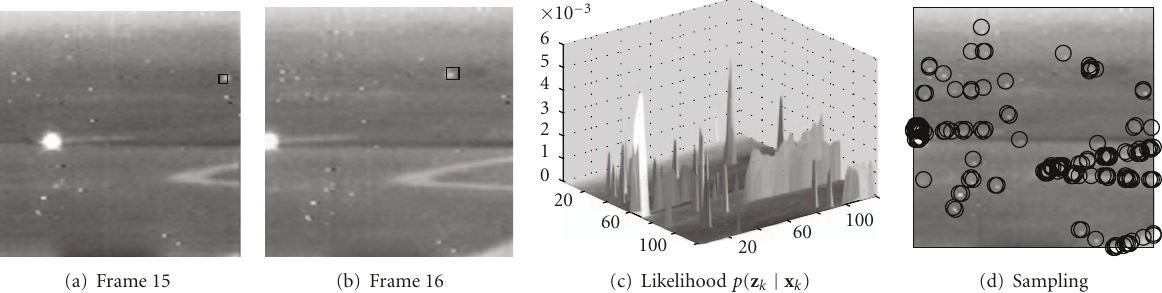
Figure 11: Common intermediate results for all the three tracking algorithms in a situation of strong ego-motion.